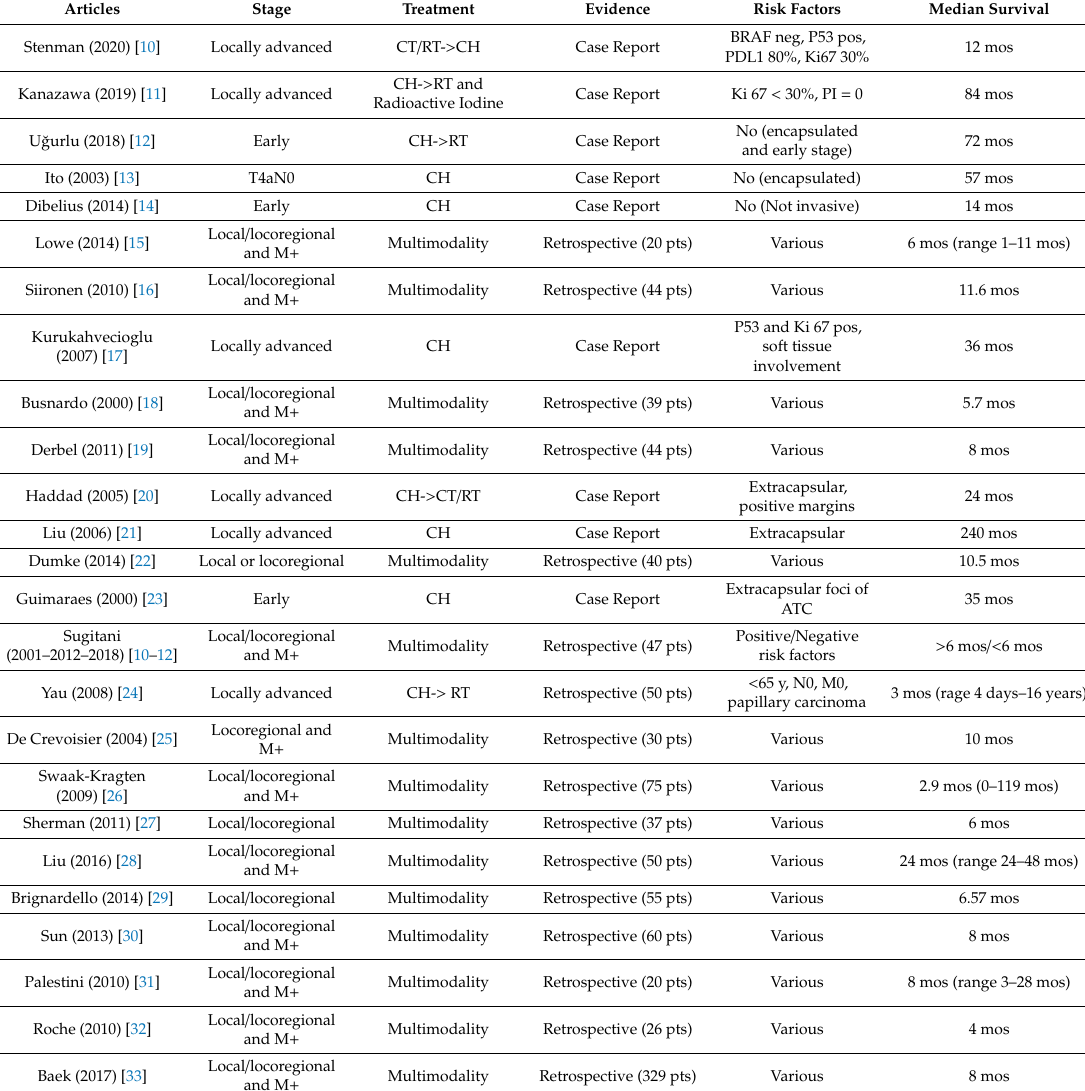
Table 1. Selection of articles regarding the long survival of ATC